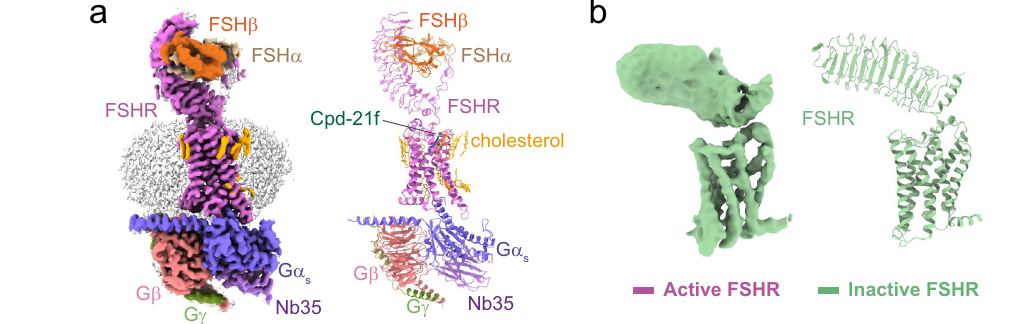
density (leftpanel)and ribbonpresentation(right panel) of theinactive FSHR, the EM density map is shown at level of